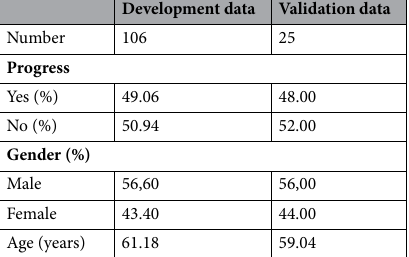
Table 1. Histopathological diagnosis and demographic data.